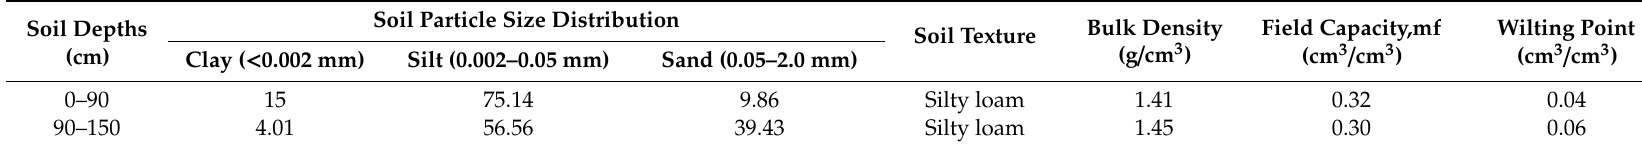
Table 2. Soil physical properties of experimental area.